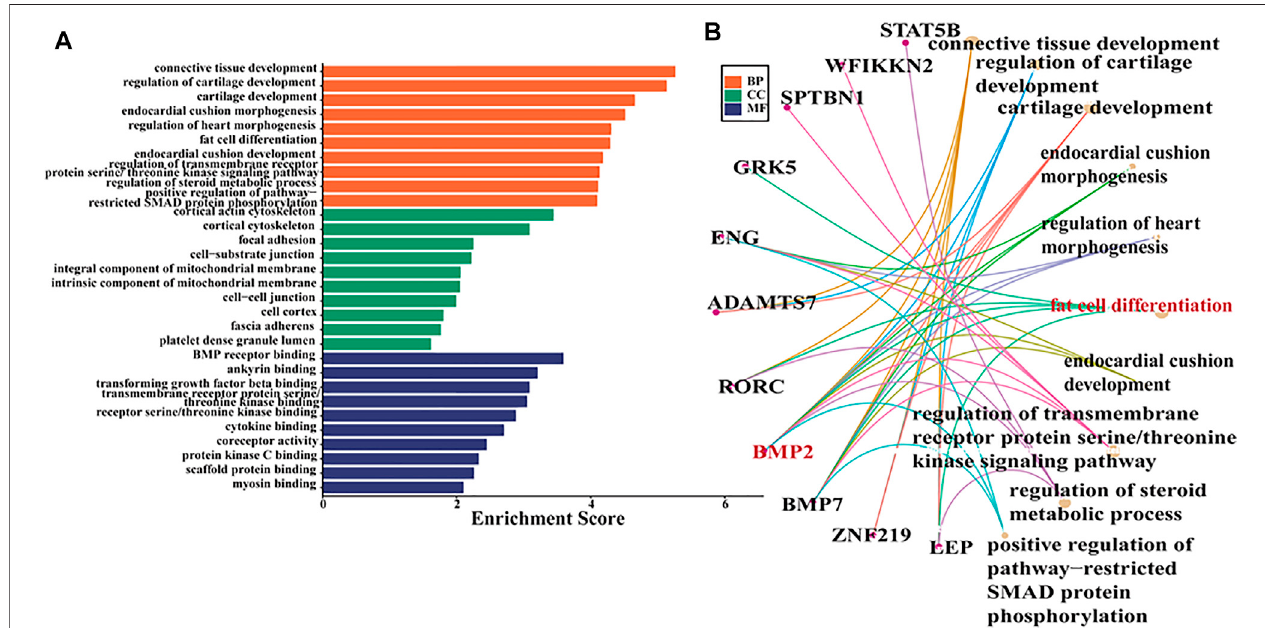
FIGURE 3 | (A) GO term for overlapped genes between DEGs and target genes of oar-miR-432. (B) GO term associated with fat deposition in the biological process group.